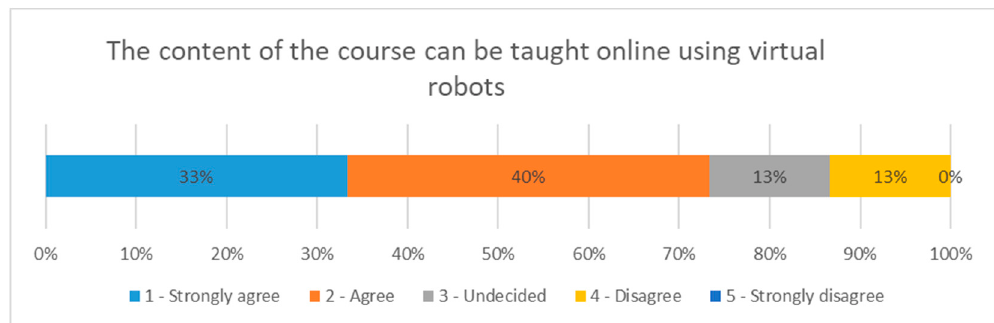
Figure 9. Expression of students’ attitudes to the statement: “The content of the course can be taught online using virtual